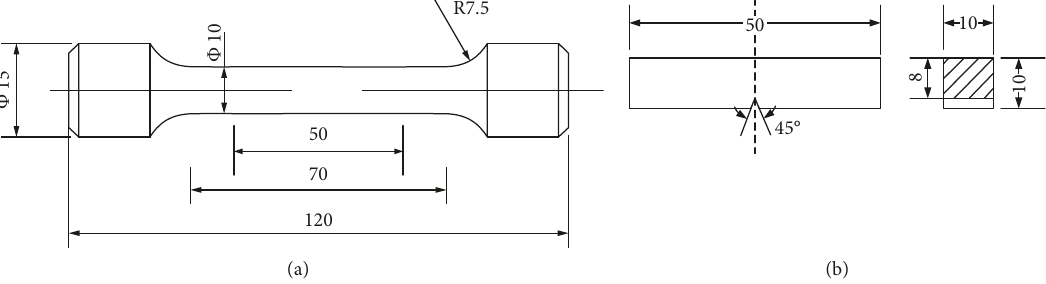
Figure 4: Schematic diagrams of the specimens (mm): (a) tensile test specimen, (b) impact test